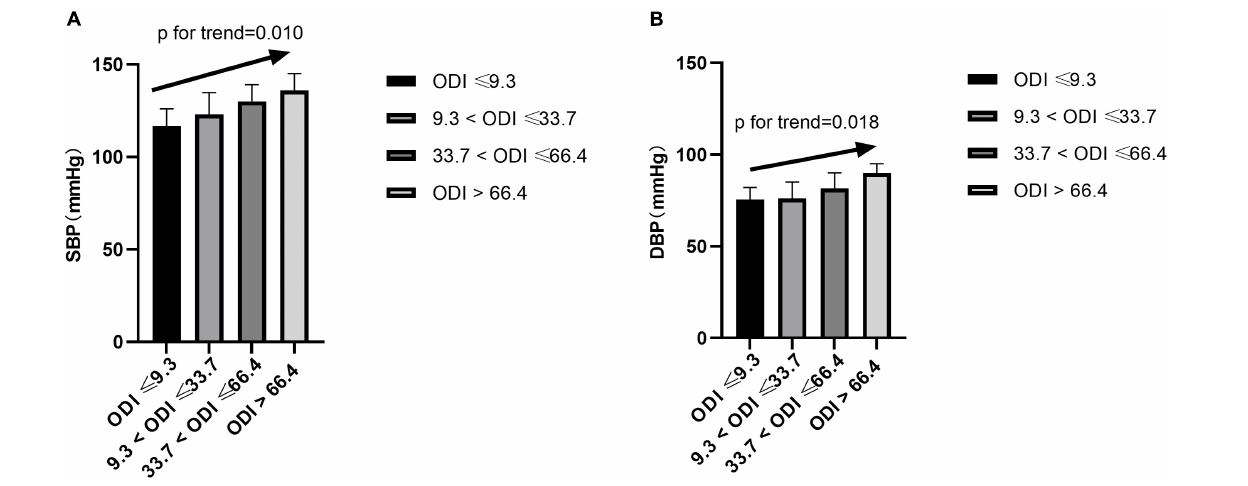
ODI ≤ 9.3, OR (95%CI) = 4.759 (1.436, 15.770), p = 0.011] ( Table 3 and Model